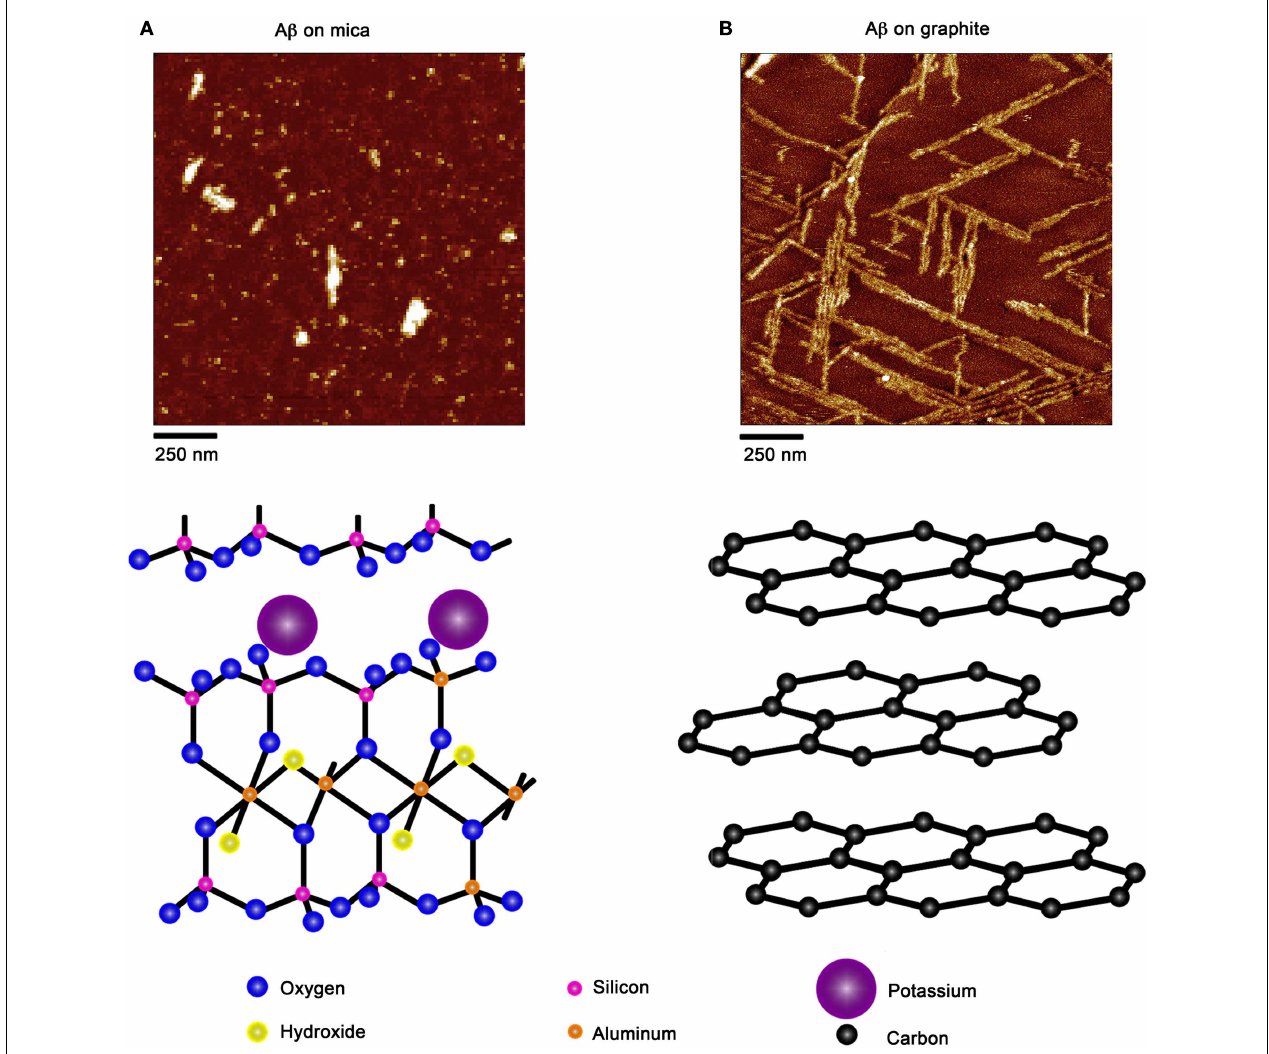
hydrophobic carbon lattice. (B) On a negatively charged, hydrophilic mica surface, A β forms discrete oligomers that maintained some lateral mobility along the plane of the surface.These oligomers could organize into elongated protofibrillar structures. Schematic representations of the structure of each surface (graphite and mica) are provided under each